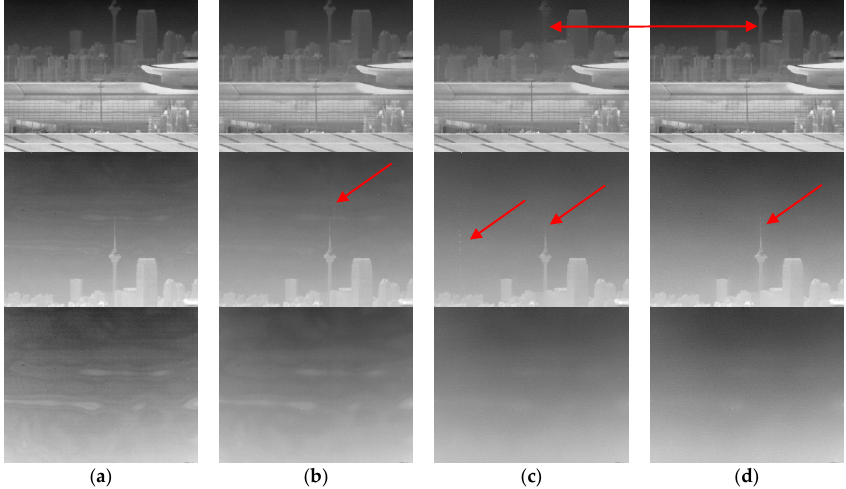
Figure 12. NUC performance comparison of the infrared sequence. ( a ) The original image; ( b ) ST-LMS; ( c ) THP & GM; and ( d ) our method. The upper row corresponds to frame 106, the middle row corresponds to frame 290, and the bottom row is frame 390.